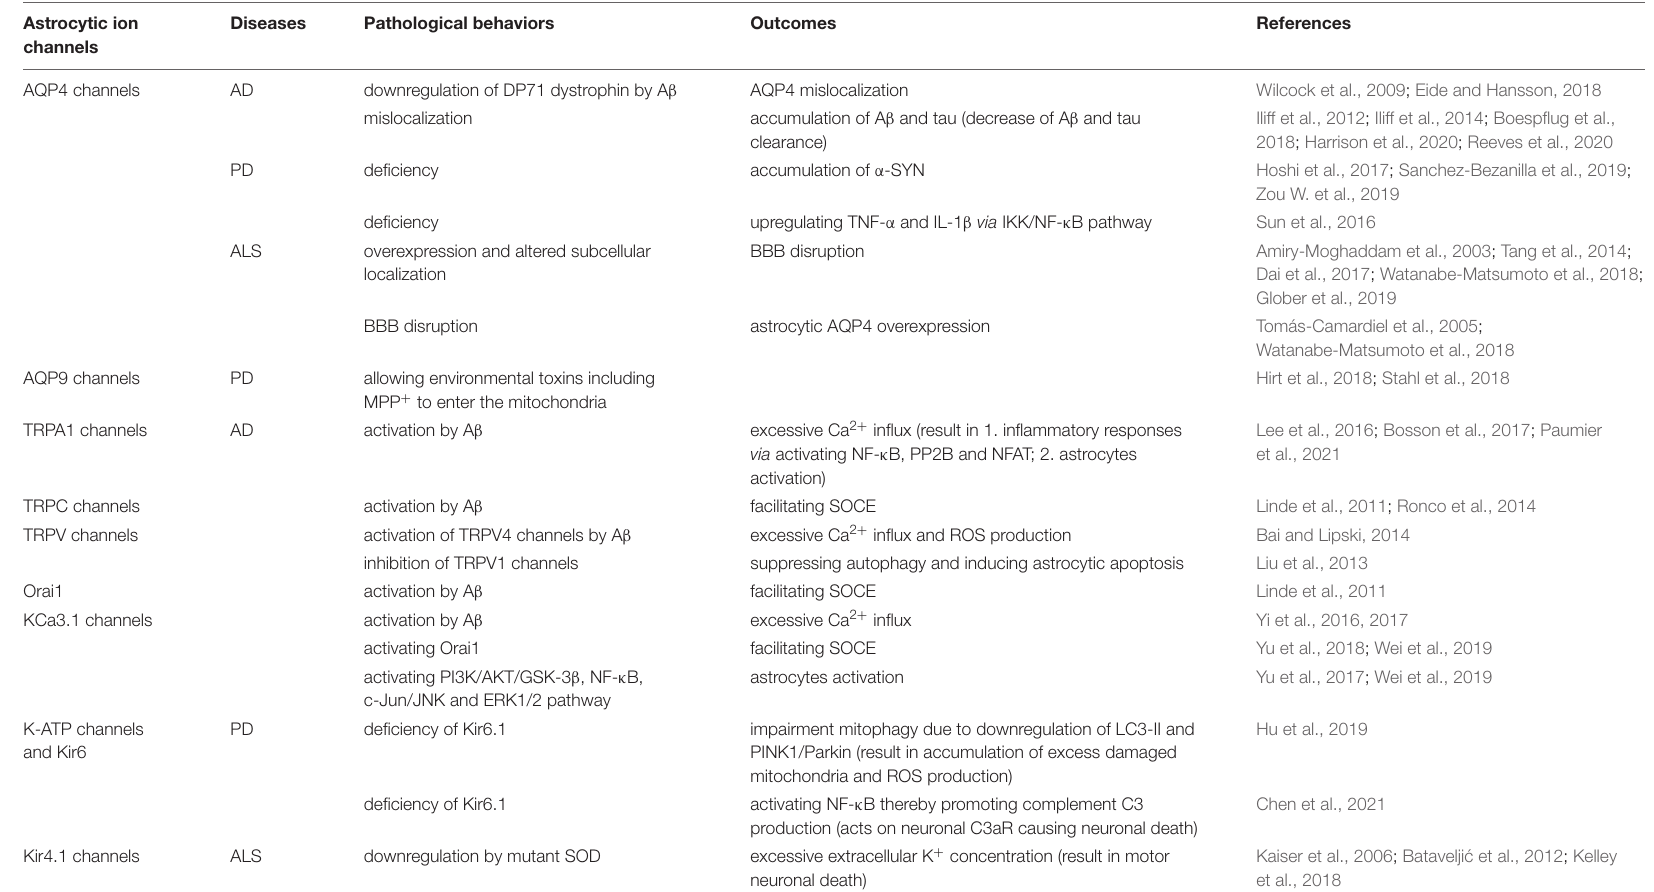
TABLE 1 | Pathological manifestations of astrocytic ion channels in neurodegenerative